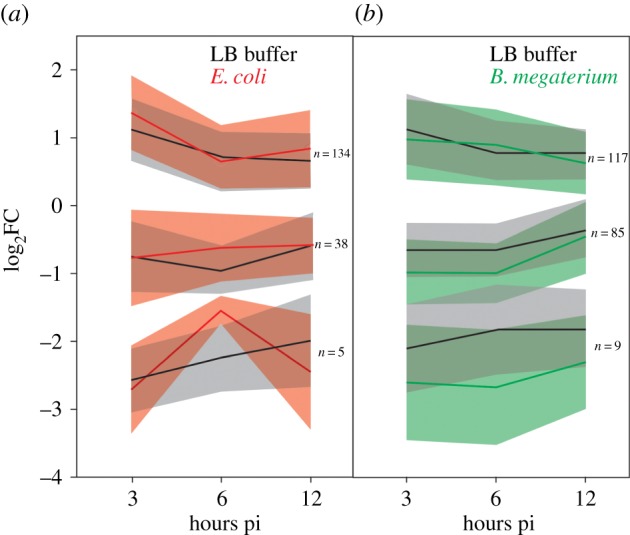
Spider mites do not trigger an induced immune response against bacterial infection. T. urticae adult females were infected with E. coli, B. megaterium and LB buffer by an injection method and collected 3, 6 or 12 h post-infection (pi) to analyse the transcriptomic responses. Using non-injected mites as a reference, the relative transcription levels of the gene sets that showed significant differential expression in any time point of each bacterial and LB-control treatment were subjected to hierarchical clustering based on the distance calculated by dynamic time warping alignments. Resulting clusters were grouped, of which the means (solid line) and confidence interval (α: 0.05) (shaded regions) are shown for infections with E. coli (in red) (a) or B. megaterium (in green) (b) together with their respective LB controls (in black).